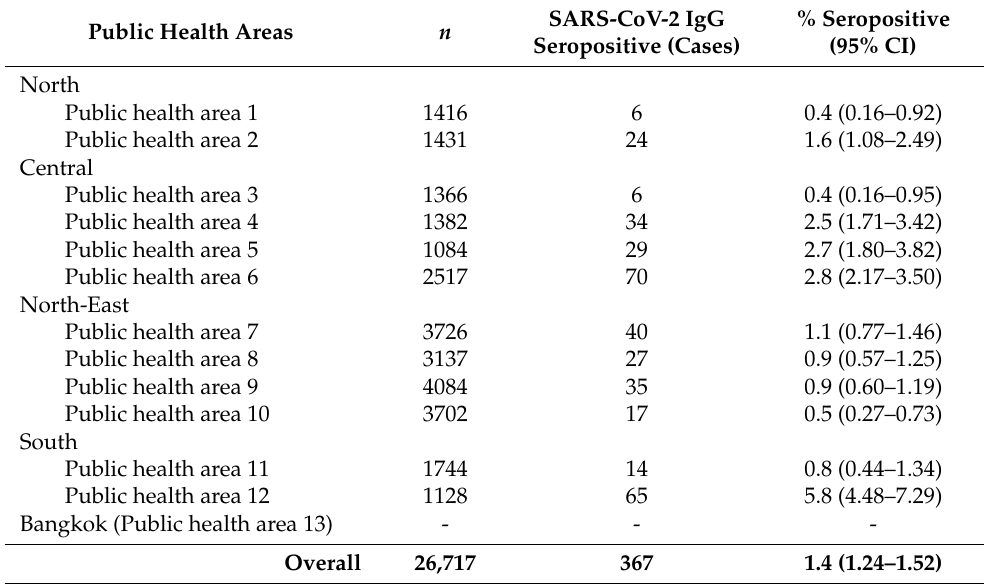
Table 2. Percentage of seropositive participants by the geography of